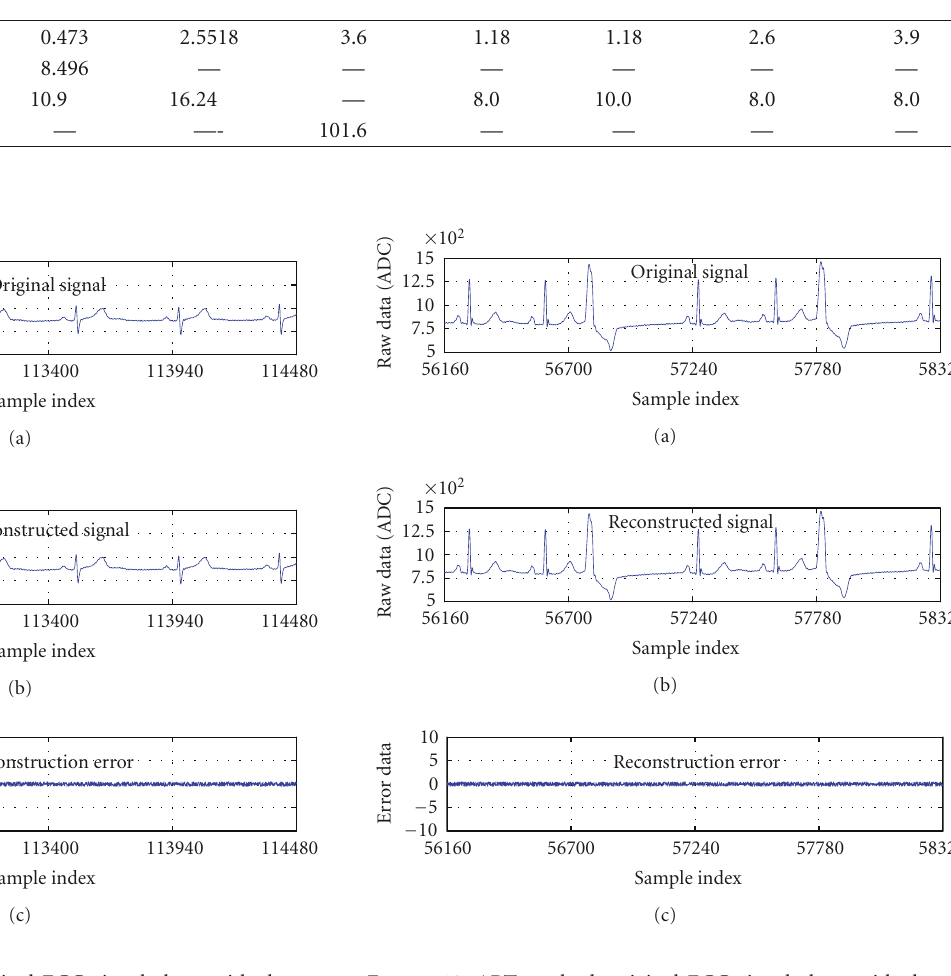
Figure 13: ABT method: original ECG signal along with the re- constructed and residue signals of MIT-BIH ADB record 119MLII